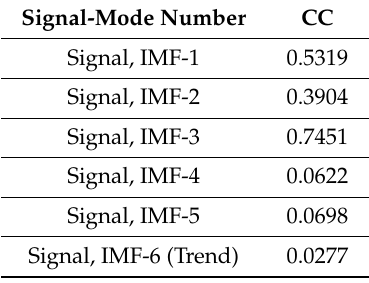
Table 3. Correlation Coefficient (CC) values of the TCPI modes and the signal derived from Dataset-3.